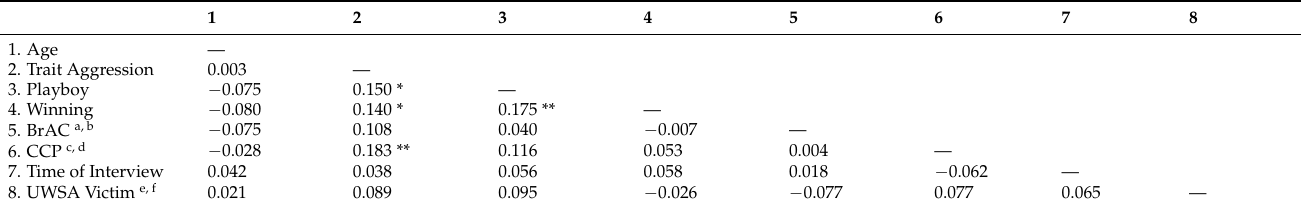
Table A1. Pearson and Point-Biserial Correlations for Females between Age, Trait Aggression, Playboy, Winning, Breath Alcohol Content, Childhood Corporal Punishment, Time of Interview and UWSA Victimisation.